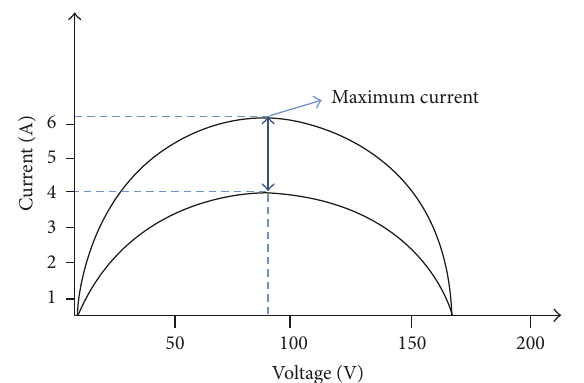
Figure 16: The response of the SB 1700E inverter to change of the additional series